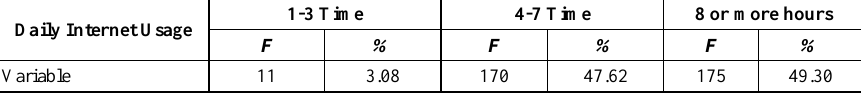
Table 2. The distribution of the university students on the daily internet